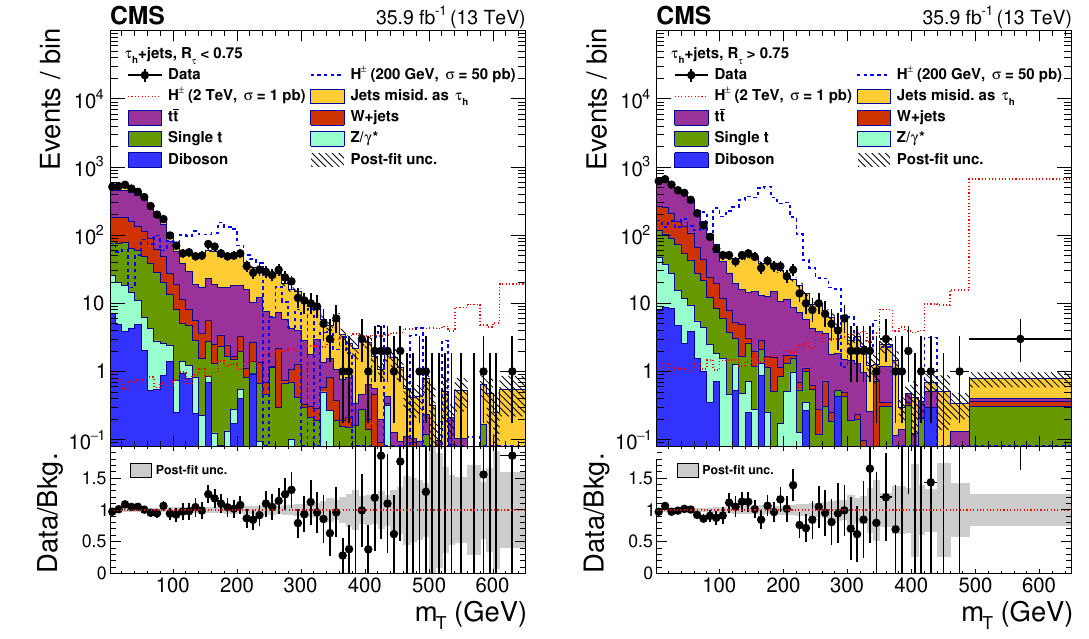
Figure 3 . The transverse mass distributions in the t (cid:12)t to the data. Left: category de(cid:12)ned by R